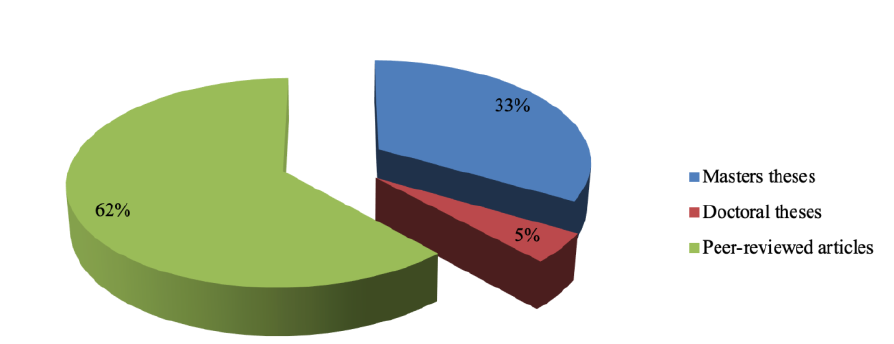
Figure 2: Categories of reviewed studies